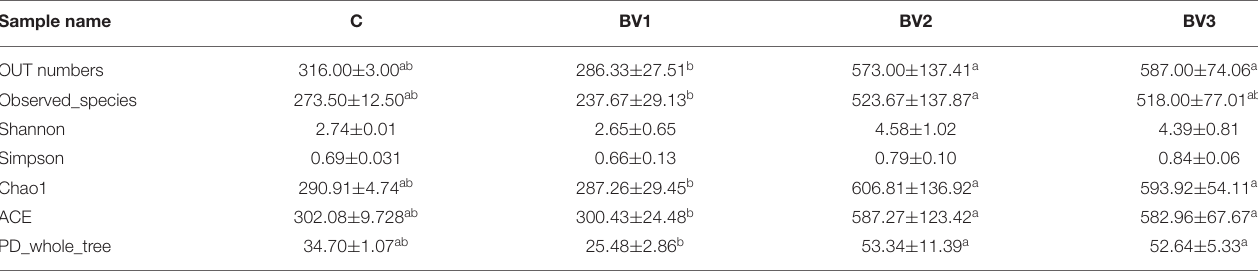
TABLE 6 | Operational taxonomic unit (OTU) numbers, species richness, and diversity indices for the intestinal microbial community diversity analysis of L. vannamei fed different levels of B. velezensis BV007.